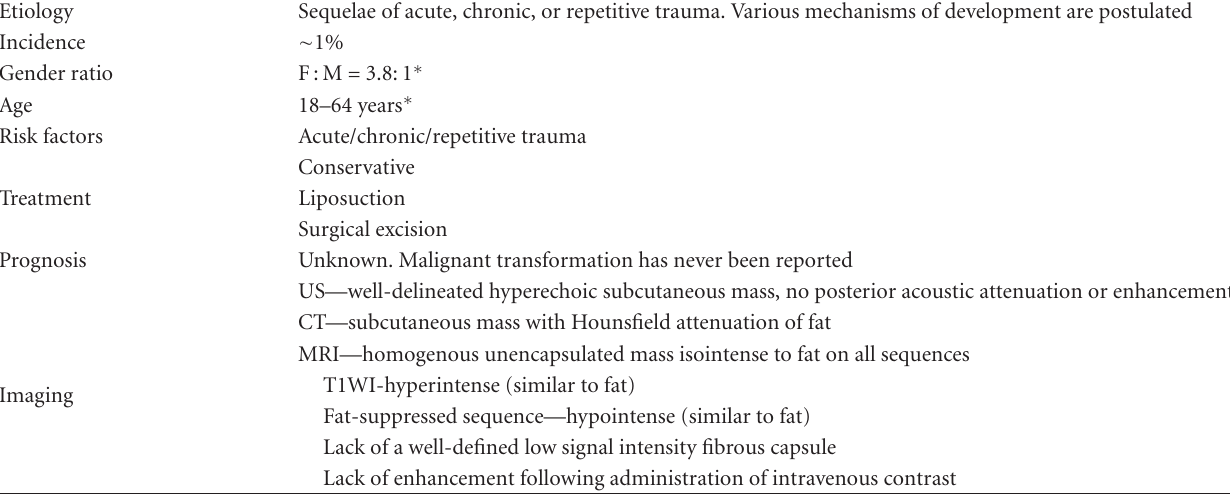
Figure 1: 4cm nontender midline soft tissue mass in the interscapular region in a 37-year-old male “tar barreler.” Table 1: Summary table: posttraumatic pseudolipoma (PTL).